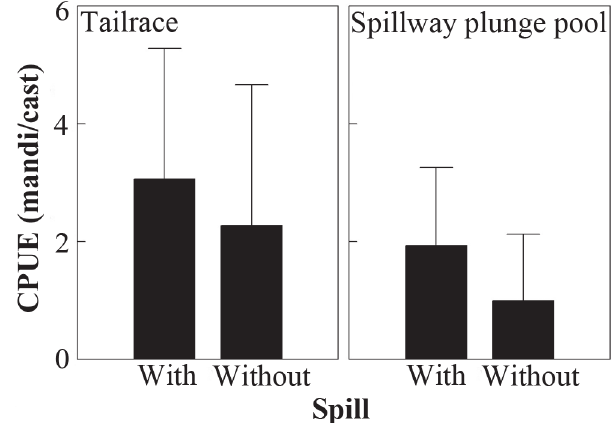
Fig. 3. Mean plus one standard deviation of the CPUE of mandi in the tailrace (left panel) and in the spillway plunge pool area (right) at Três Marias Dam with and without